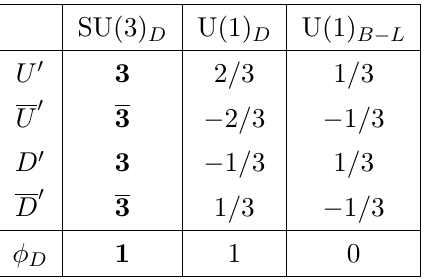
is the global symmetry B − L